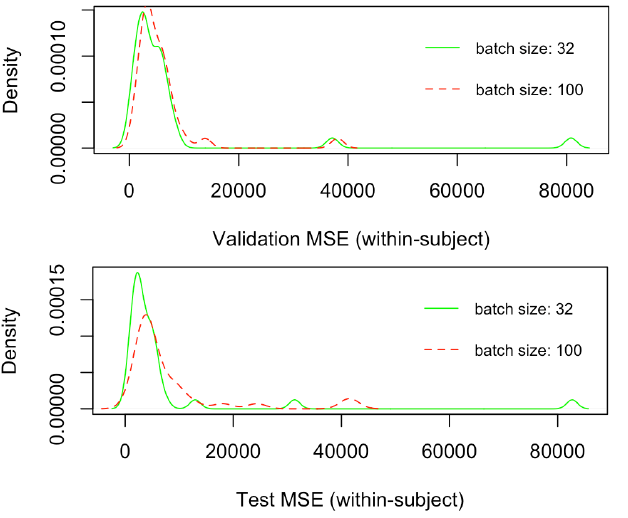
Figure 6. Comparison of validation and test Mean Squared Error for within-subjects CNN models trained, respectively, with batch size of dimension 32 and